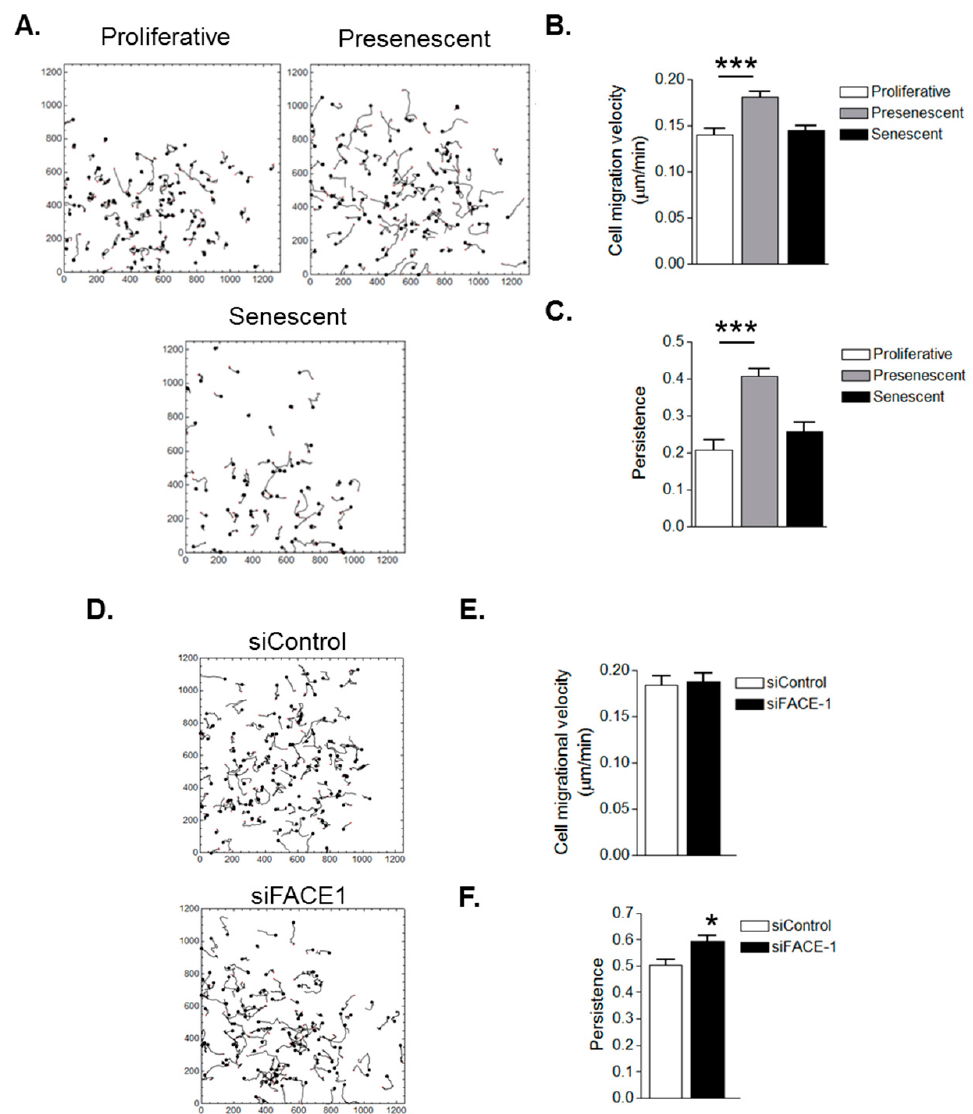
Figure 5. In Vitro ageing and prelamin A accumulation stimulate VSMC migrational persistence. ( A ) Analysis of randomly migrating single proliferative, presenescent and senescent VSMCs; Graphs show ( B ) migrational velocity and ( C ) persistence of proliferative, presenescent and senescent VSMCs. Data are based on the analysis of 61 (senescent) and 108 (proliferative and presenescent) individually tracked cells pooled from three independent experiments (*** p ≤ 0.0001); ( D ) Analysis of randomly migrating single control and FACE1-depleted 35F VSMCs; Graphs show ( E ) migrational velocity and ( F ) persistence of control and FACE1-depleted VSMCS. Data are based on the analysis of 121 (control) and 118 (FACE1-depleted) individually tracked cells pooled from three independent experiments (* p ≤ 0.05).